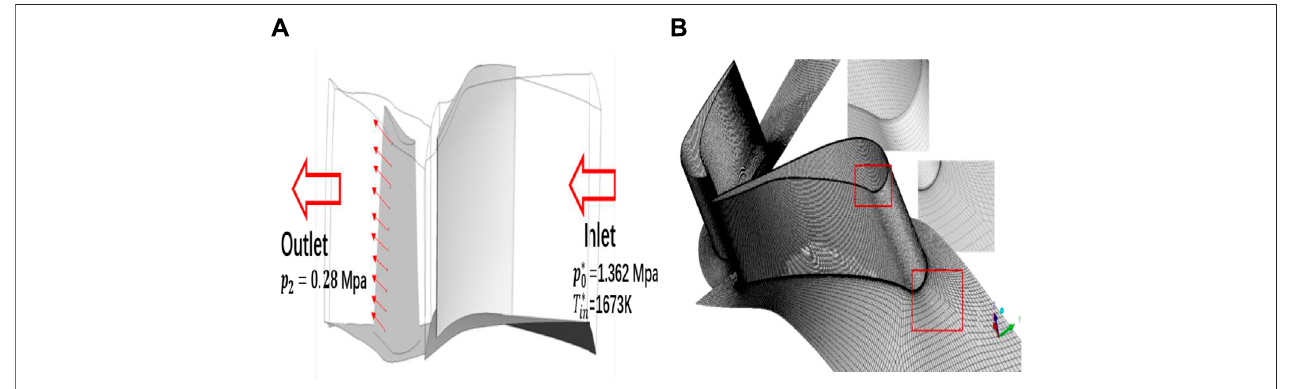
FIGURE 1 | Computational model. (A) Geometry. (B) Grid